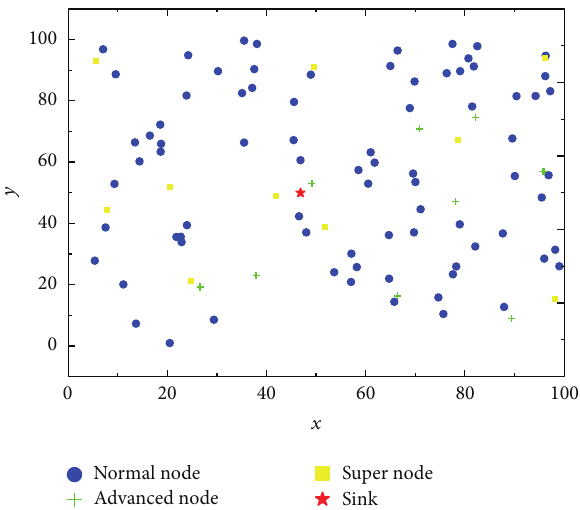
Figure 2: The network model with heterogeneity in three energy levels.